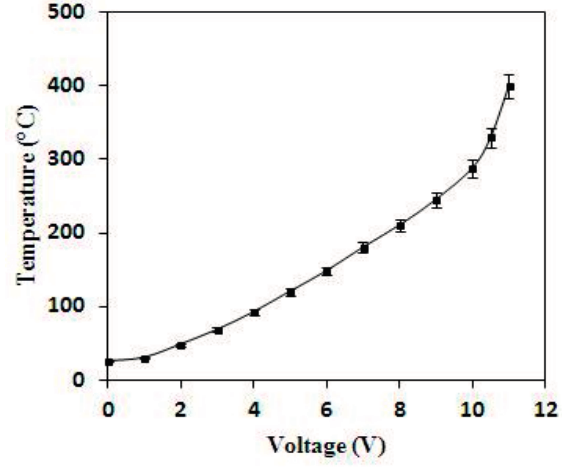
Figure 9. Measured results of the